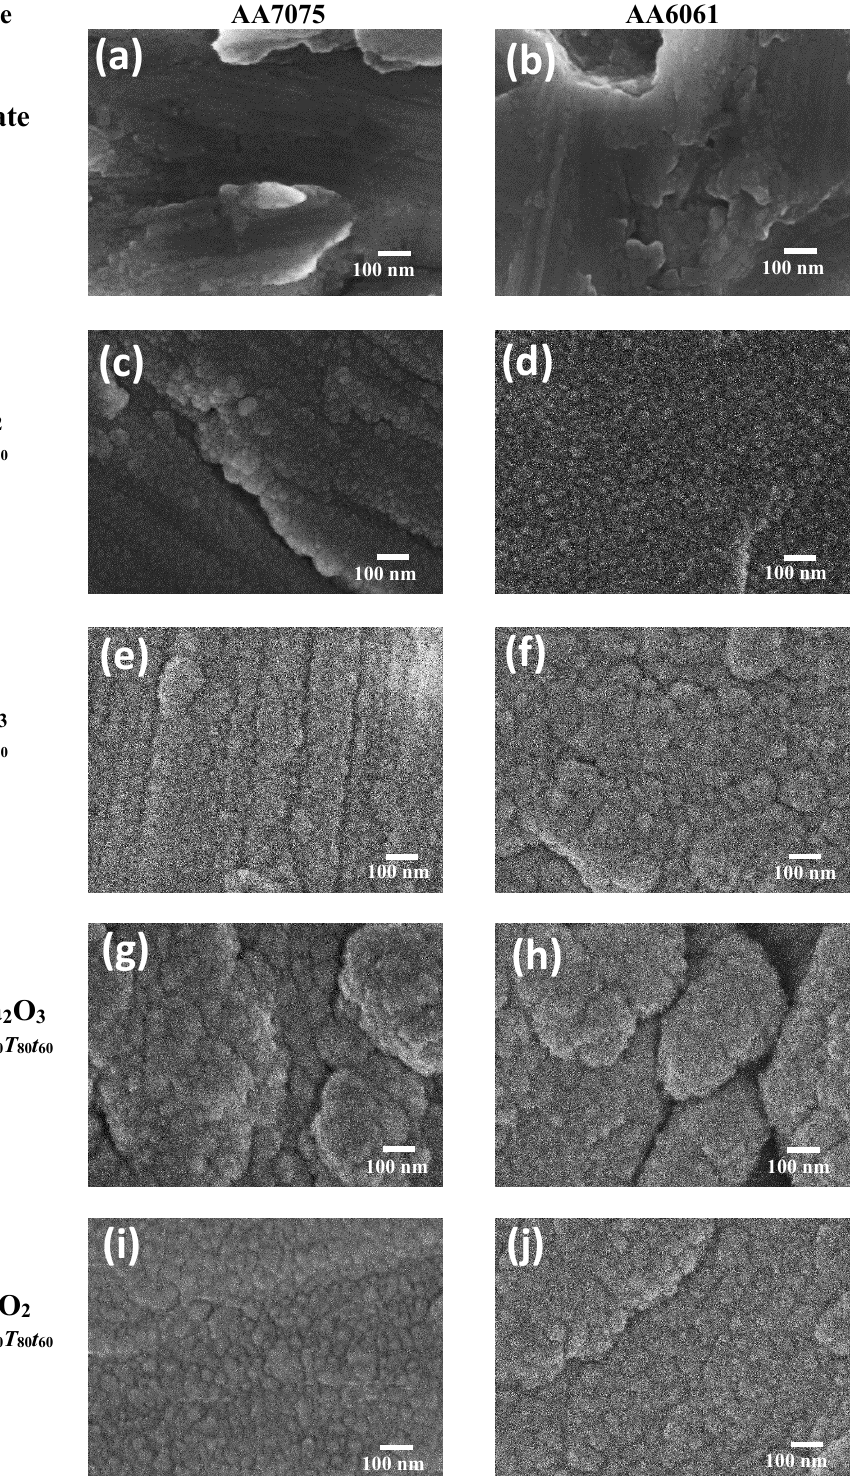
Figure 6. Typical High Resolution Scanning Electron Microscopy (HRSEM) images of oxide sputtered bilayered coatings, their corresponding comparison with pure coatings and bare aluminum. ( a ) Uncoated AA7075, ( b ) uncoated AA6061, ( c ) AA7075/Ce ( P 80 T 80 t 60 ), ( d ) AA6061/Ce ( P 80 T 80 t 60 ), ( e ) AA7075/La ( P 60 T 80 t 60 ), ( f ) AA6061/La ( P 60 T 80 t 60 ), ( g ) AA7075/Ce/La ( P 80 T 80 t 60 /P 60 T 80 t 60 ), ( h ) AA6061/Ce/La ( P 80 T 80 t 60 /P 60 T 80 t 60 ), ( i ) AA7075/La/Ce ( P 60 T 80 t 60 /P 80 T 80 t 60 ), and ( j ) AA6061/La/Ce ( P 60 T 80 t 60 /P 80 T 80 t 60 ).